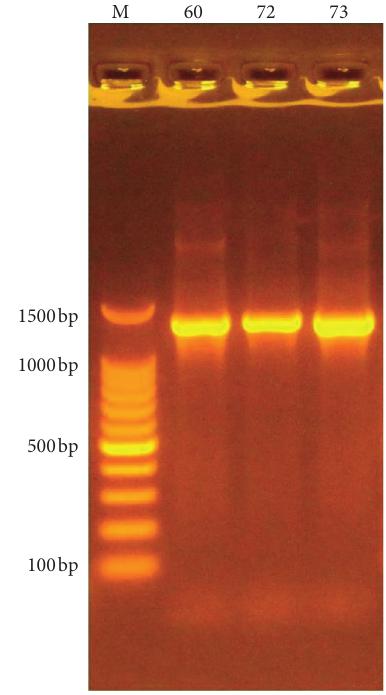
Figure 1: The amplification of species-specific primer1306bp for P. rettgeri / P. vermicola genes of isolates, fractionated on agarose gel electrophoresis 1% stained with Eth. Br, M 100bp DNA marker (60, 72, and 73 refer to the no. of Providencia species